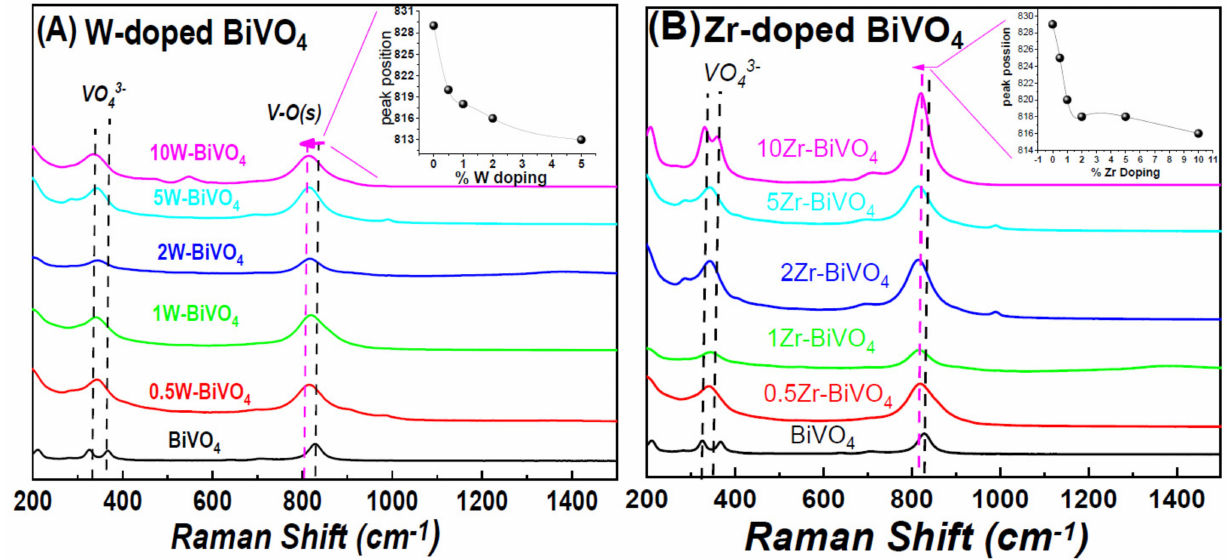
Figure 2. Raman spectra for the FSP-made BiVO 4 -based photocatalysts: ( A ) W-doped nanomaterials and ( B ) Zr-doped nanomaterials. Insert: shift of Raman V-O(s) peak at 830 cm − 1